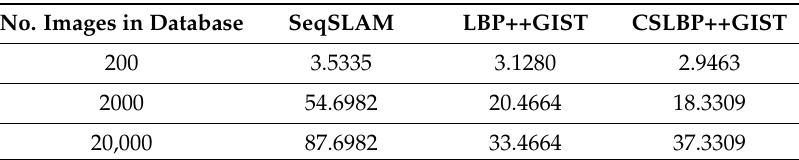
Table 3. Comparison of average processing times for image matching